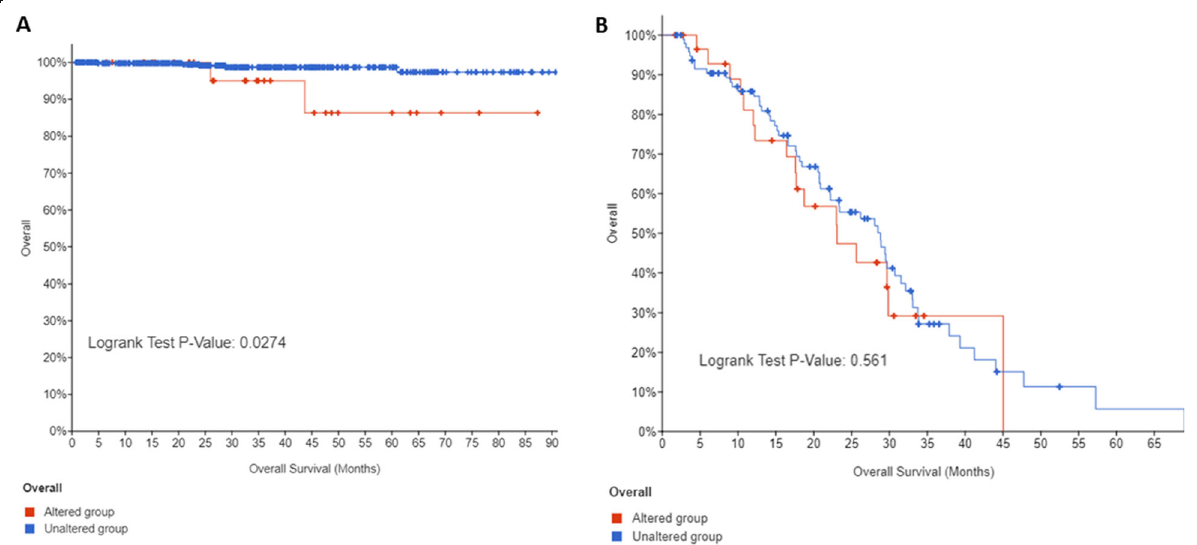
Fig. 2 Overall survival of patients with or without alterations in TERF1. A Kaplan – Meier plot from primary tumor. B Kaplan – Meier plot from